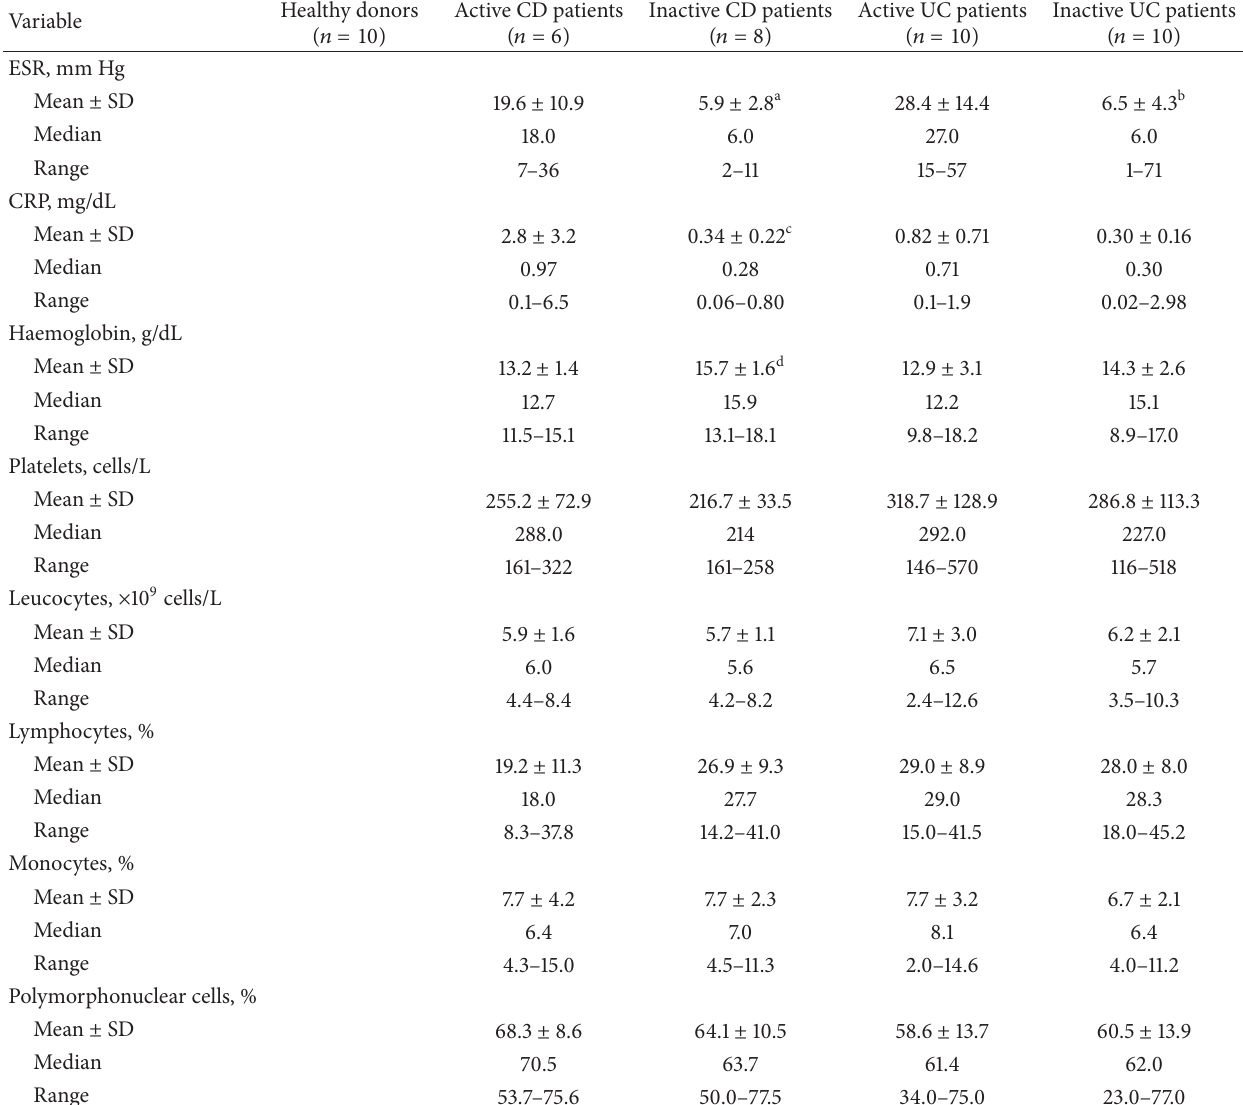
Table 2: Laboratory variables of Crohn’s disease and ulcerative colitis